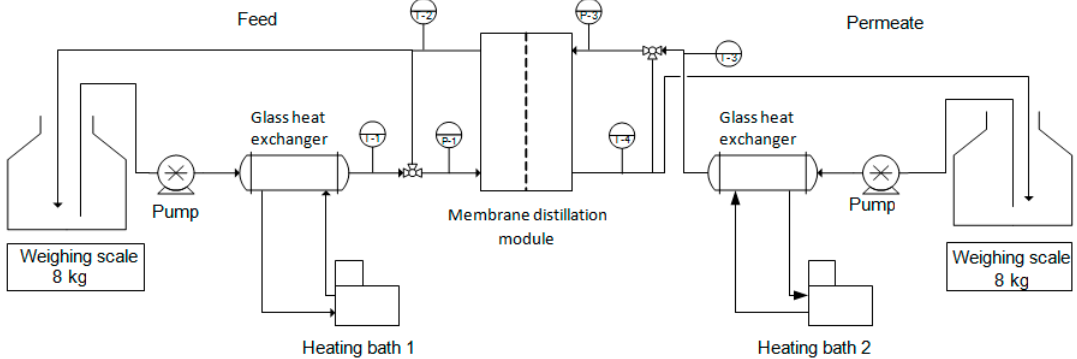
Figure 6. Schematic of the membrane distillation setup.